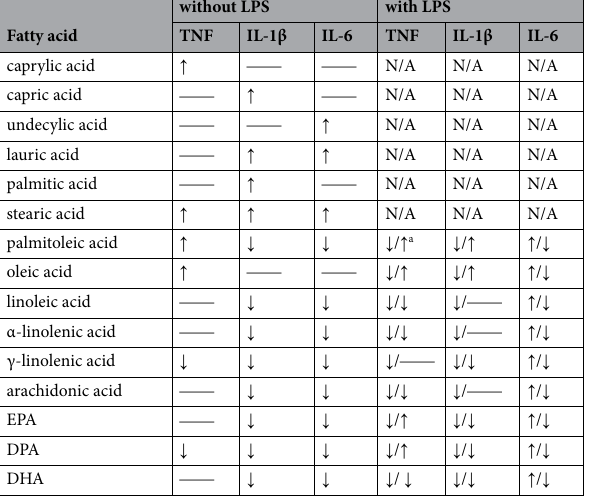
Table 2. Summary of the effects of selected fatty acids on the productions of TNF, IL-1β, and IL-6 in the THP-1 monocytes cultured with and without LPS treatment. ↑ : increase; ↓ : decrease; ― : unchanged; a : trend at low concentration/trend at high concentration of